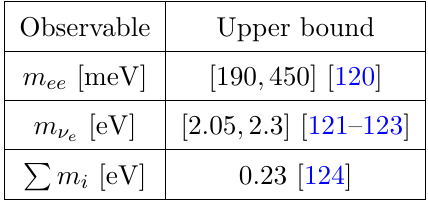
Table 6. The current experimental 95 % C.L. upper bounds on parameters related to the neutrino masses, see also section 2.3. The two upper bounds on m ee are due to the sensitivity on the nuclear matrix elements, whereas for m (cid:23) , we show results coming from two di(cid:11)erent experiments. We use e the most stringent values of these two upper bounds in the